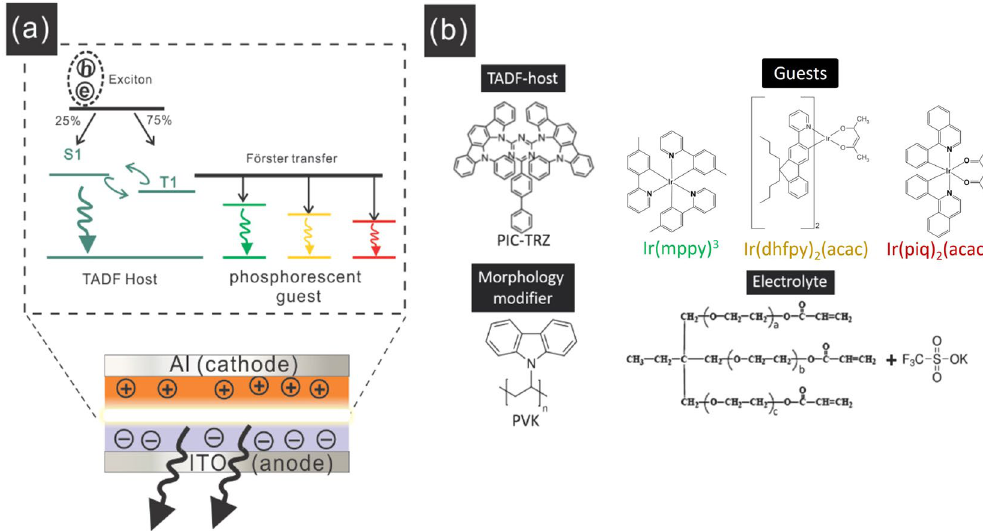
Figure 1. ( a ) Schematics for the emission mechanisms in TADF-LECs, ( b ) chemical structure of the TADF host, P.D. molecules, morphology modifier and electrolyte employed in this work.